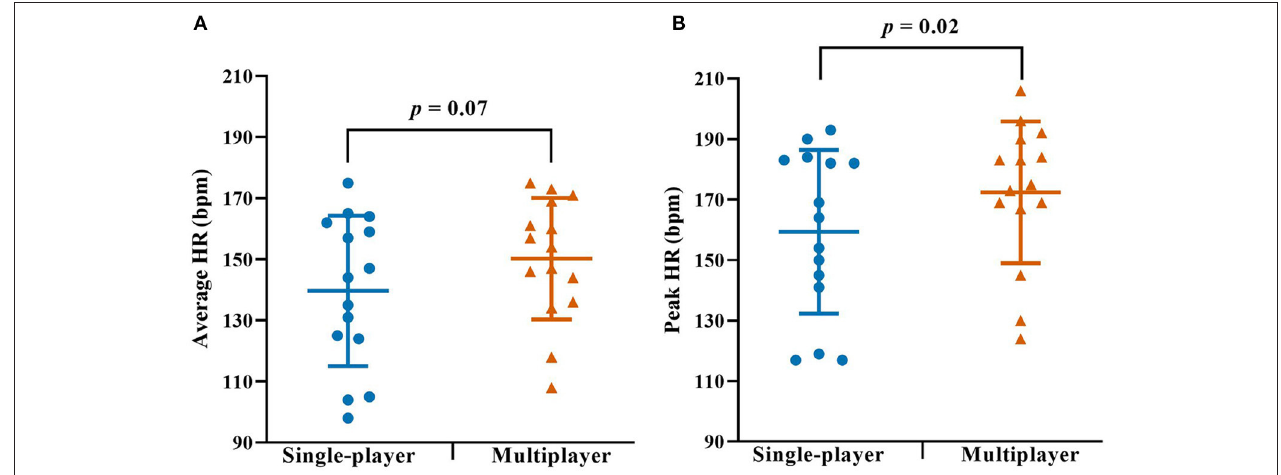
FIGURE 4 | Heart rate during single- and multiplayer exergaming. (A) Average heart rate (HR) and (B) peak HR during the single- (blue circles) and multiplayer (vermillion triangles) exergaming sessions. Individual data with group means and SD are displayed. P -values are from the paired samples t-test.